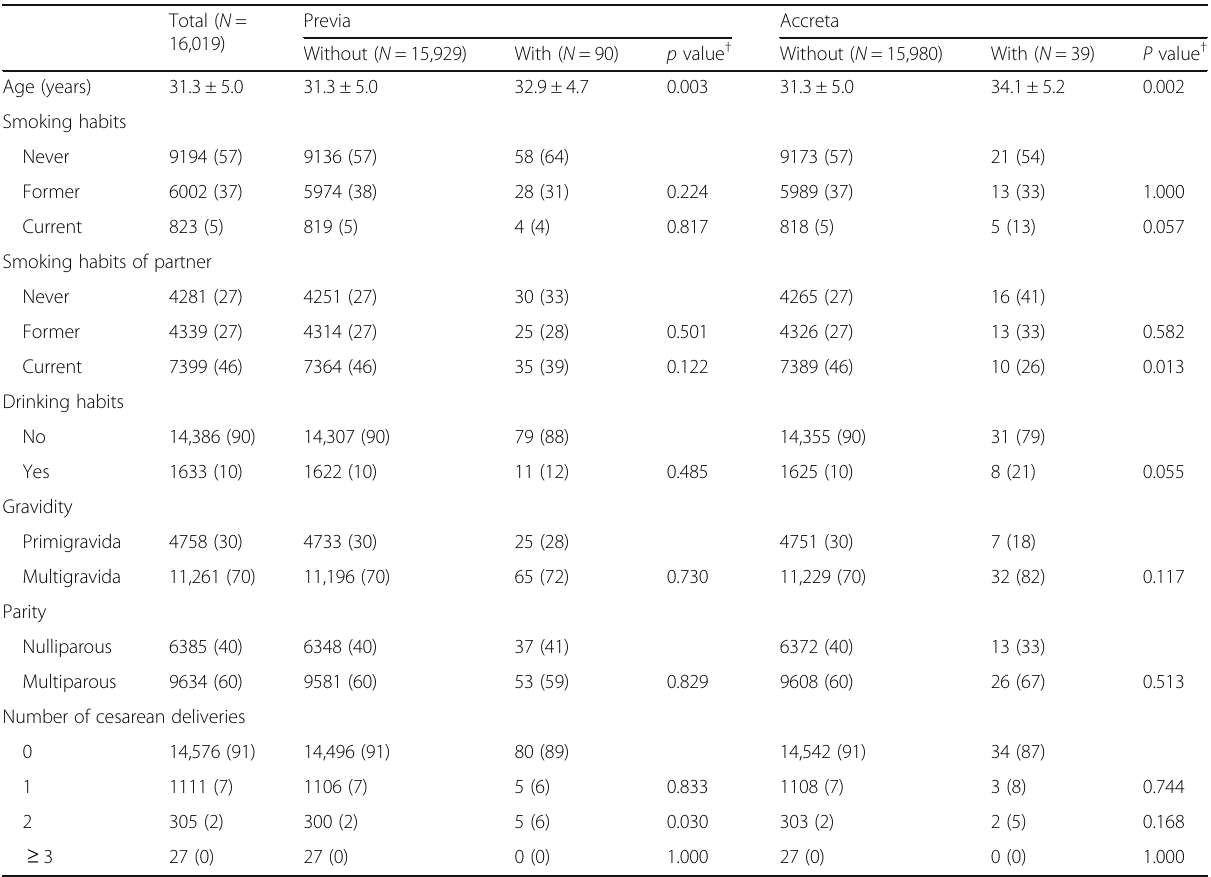
Table 1 Study population characteristics